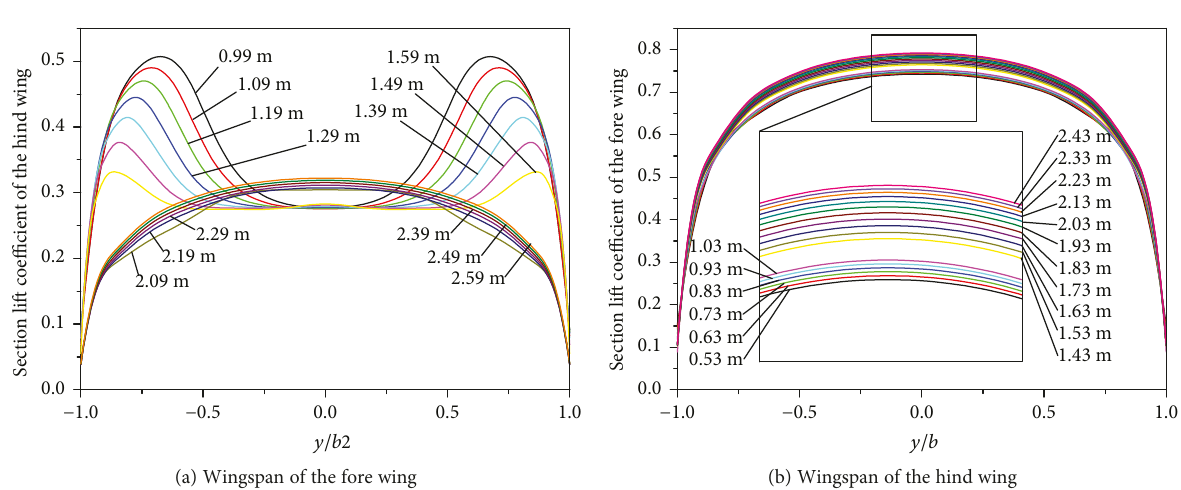
Figure 17: E ff ect of wingspan on section lift coe ffi cient for tandem wing con fi